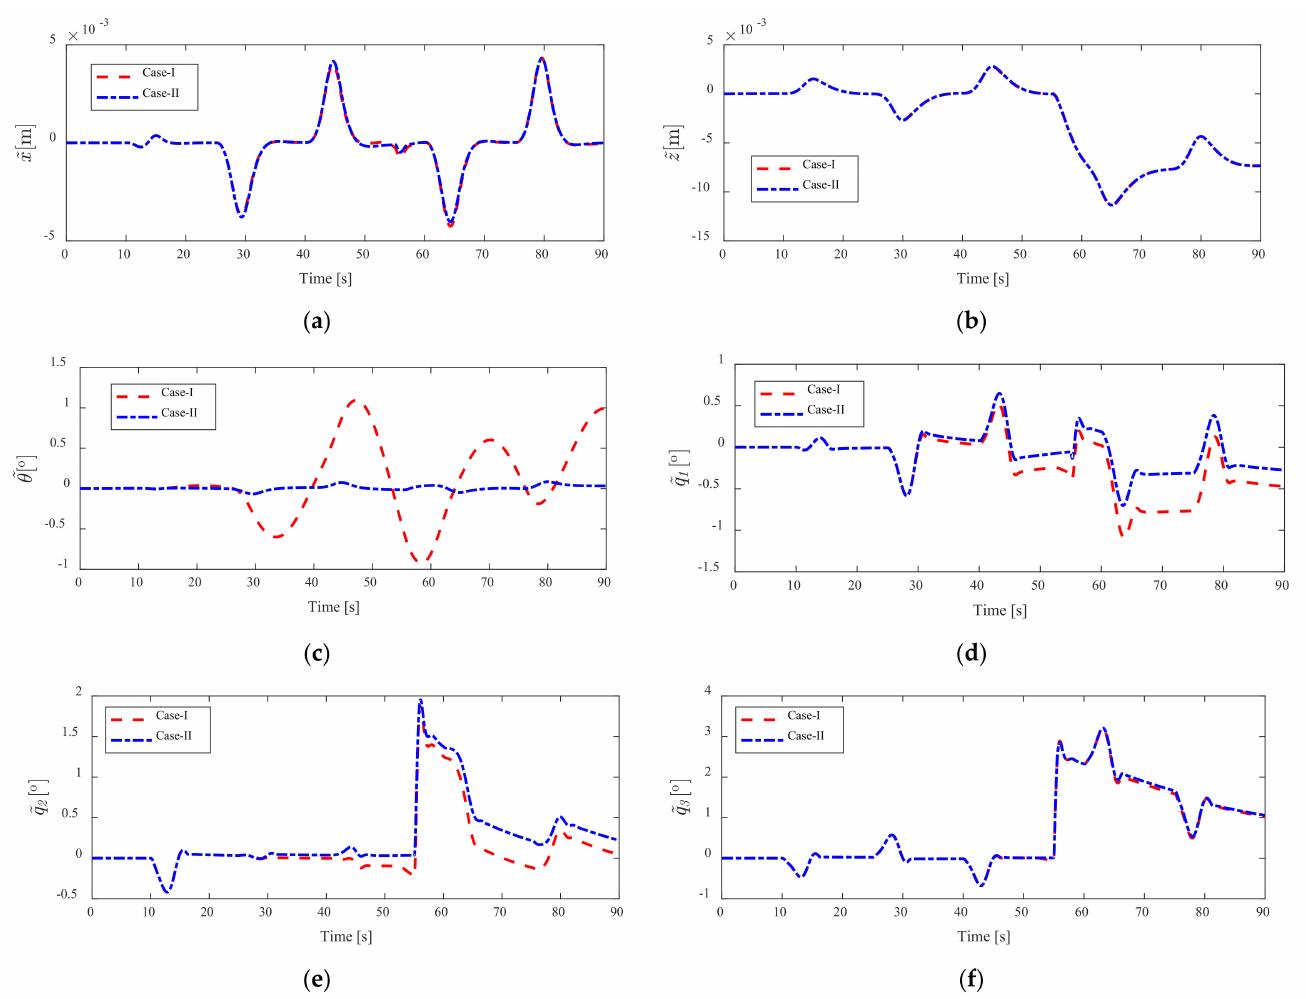
Figure 16. Vehicle and manipulator errors responses: ( a ) vehicle position error response in x-direction; ( b ) vehicle position error response in z-direction; ( c ) vehicle attitude error response; ( d ) joint q 1 error responses; ( e ) joint q 2 error responses; ( f ) joint q 3 error